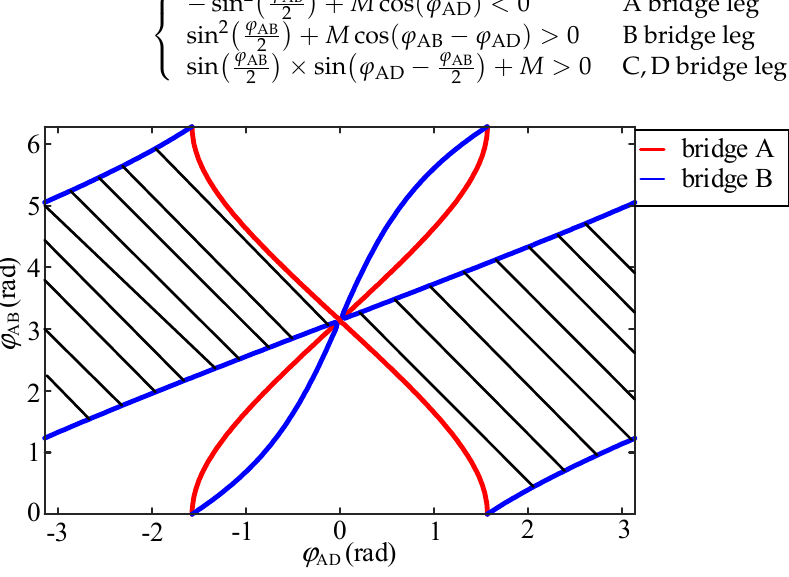
Figure 6. ZVS area under EPS modulation.